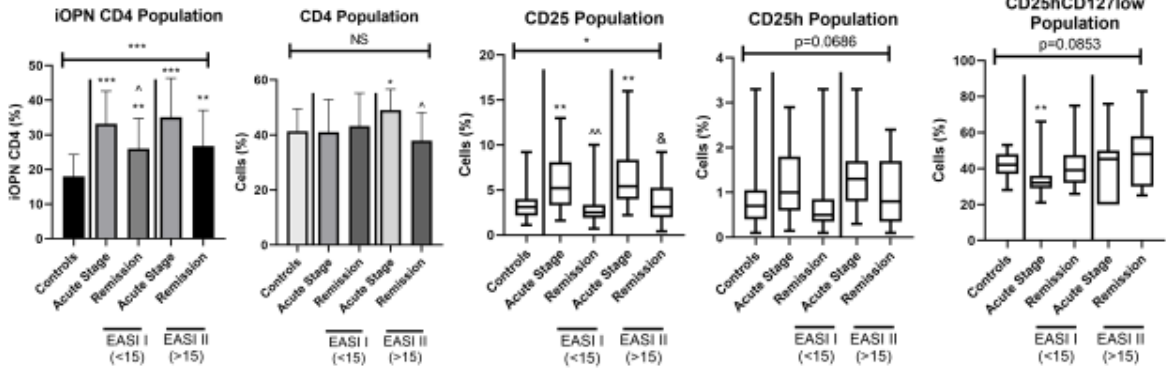
Figure 2. The percentage of selected T lymphocytes according to severity of ACD. iOPN CD4, CD4 T lymphocytes with expression of intracellular osteopontin; CD4, CD4 positive T lymphocytes; CD25, subset of CD4 positive T lymphocytes; CD25h, CD25 high T lymphocytes; CD25hCD127low, CD25highCD127low T cells—regulatory T cells; NS, non-significant; EASI I (<15), Eczema Area and Severity Index in patients with mild to moderate course of the disease; EASI II (> 15), Eczema Area and Severity Index in patients with severe course of the disease; * means statistical significance with p values < 0.05 between patients with acute stage of ACD and controls; **/*** means statistical significance with p < 0.01 and 0.0001, respectively, between patients with acute stage of ACD and controls; ˆ/ˆˆ means statistical significance with p values < 0.05 and < 0.01, respectively, between patients with acute stage of ACD and remission; & means statistical significance with p values <